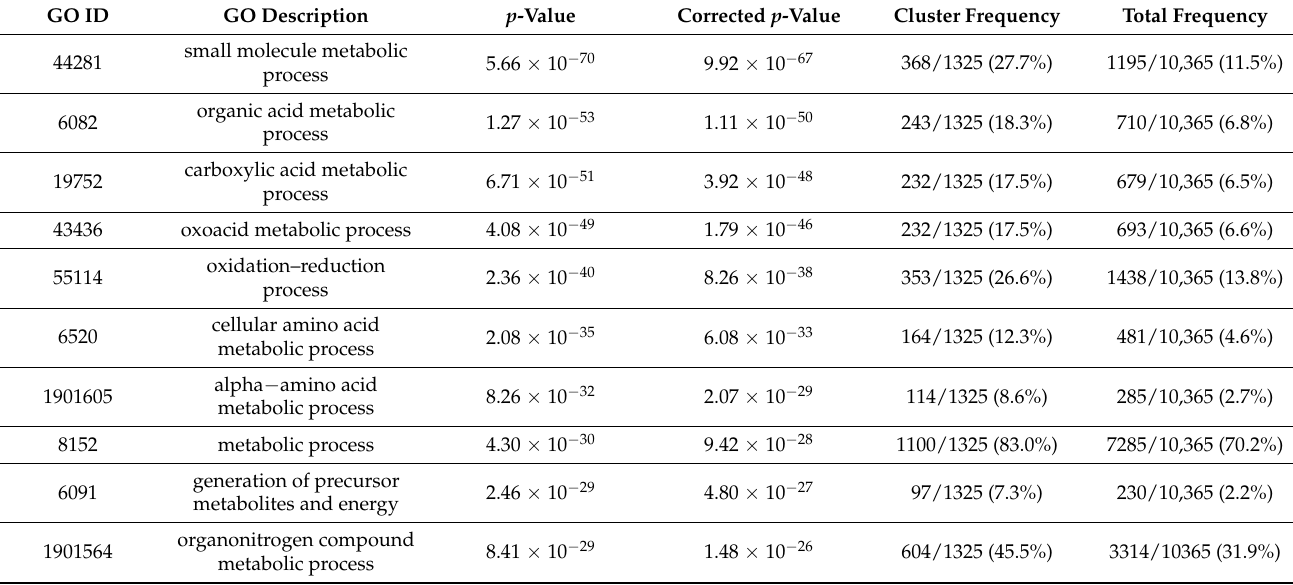
Table 1. Top 10 hits of enriched biological processes in ANOVA significant proteins from the comparison of all truffles.